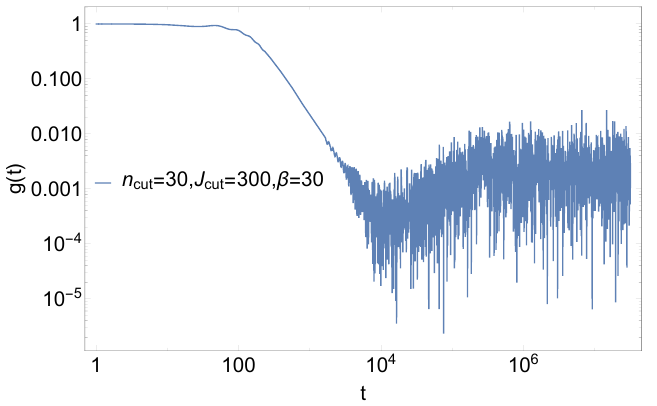
Figure 2. SFF for BTZ black hole normal modes with z 0 = 30 , J cut = 300 , n cut = 30 with β = 30